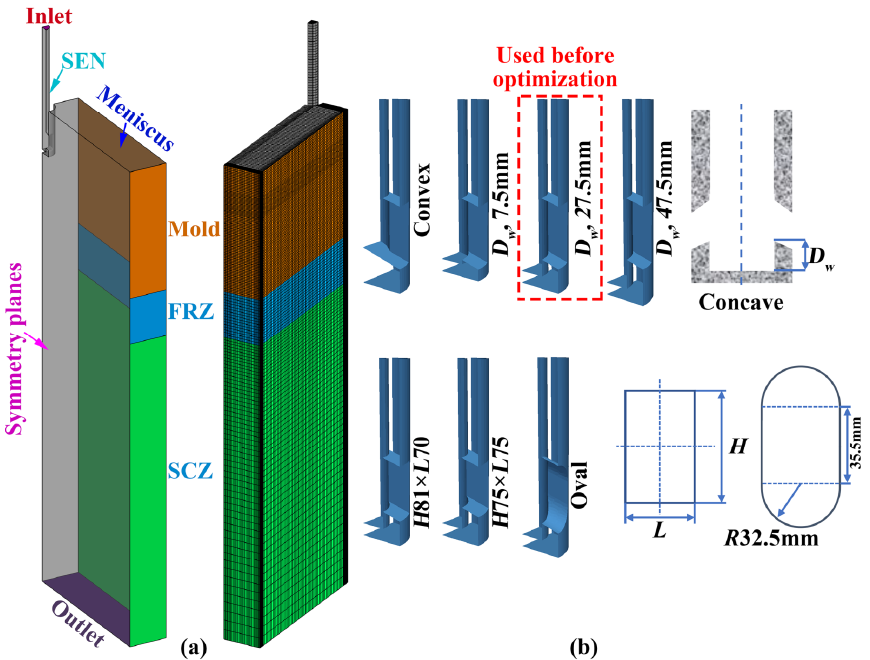
Figure 1. Schematic diagrams for geometry model and mesh used in the calculation: ( a ) the whole geome-try and mesh and ( b ) SEN structures. Table 1. The physical parameters and model parameters.